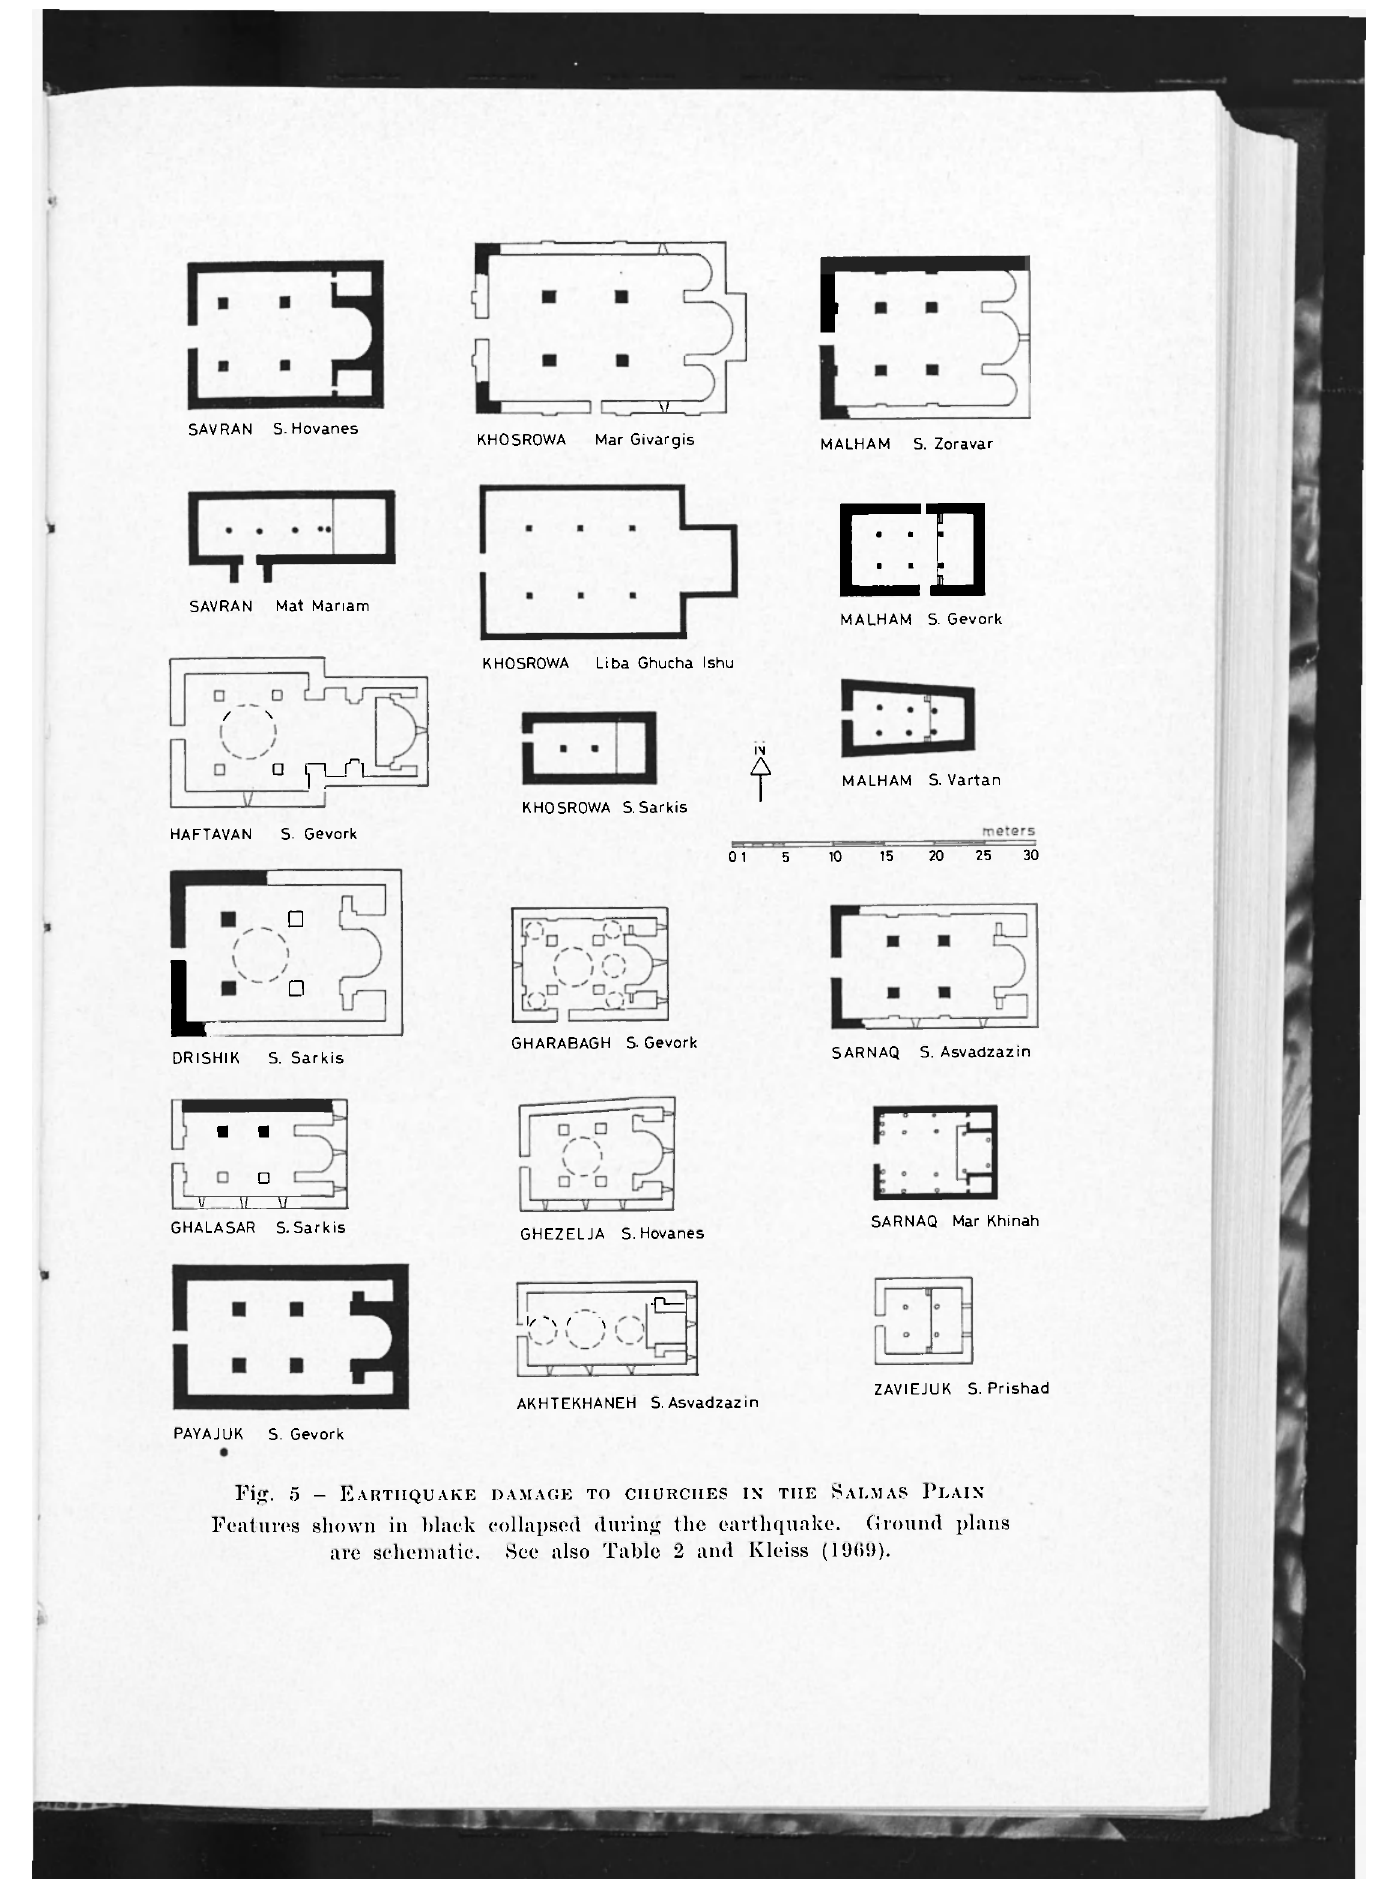
Fig. 5 - EARTHQUAKE DAMAGE TO CHURCHES IN THE SALMAS P L A IN Features shown in black collapsed during the earthquake. Ground